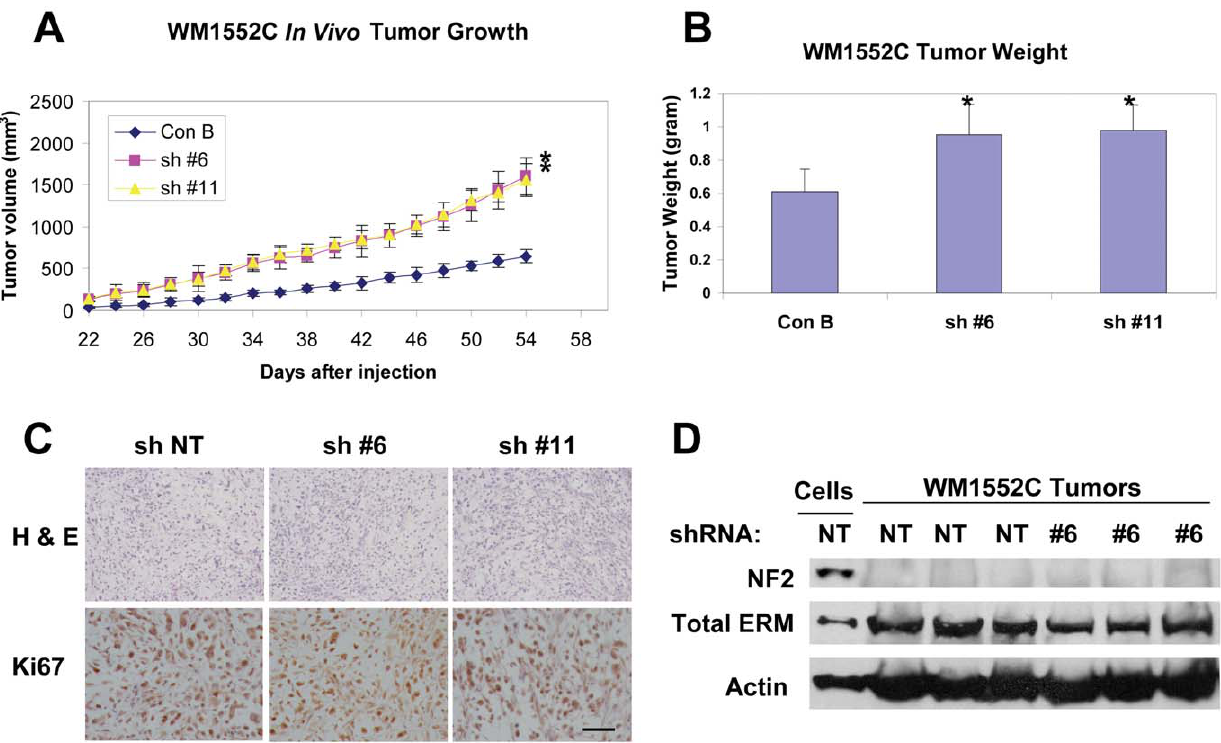
Figure 3. Merlin knockdown enhances in vivo tumor growth of WM1552C human melanoma cells. A , Growth curves of the subcutaneous tumors derived from 10 6 10 6 injected cells of indicated transduction. Numbers are mean tumor volumes (mm 3 ) + / 2 SD. *= p -value , 0.05, n=8. B , Tumor weights at the completion of the subcutaneous tumor experiments. Bars represent mean + / 2 SD tumor weights of n=8 mice/ group. *denotes p -value , 0.05. C , H & E staining and Ki67 IHC staining of the subcutaneous melanomas isolated at 54 days post injection of the tumor cells into immunocompromised Rag2/II2rg mice. Bar, 80 m m. D , Western blot analysis of merlin and total ERM protein levels in WM1552C cells transduced with non-targeting shRNA (Lane 1) or in the WM1152C tumor lysates derived from the indicated transduced cells (Lanes 2–7). 50 m g of protein was loaded into each lane and actin was included as a loading control.